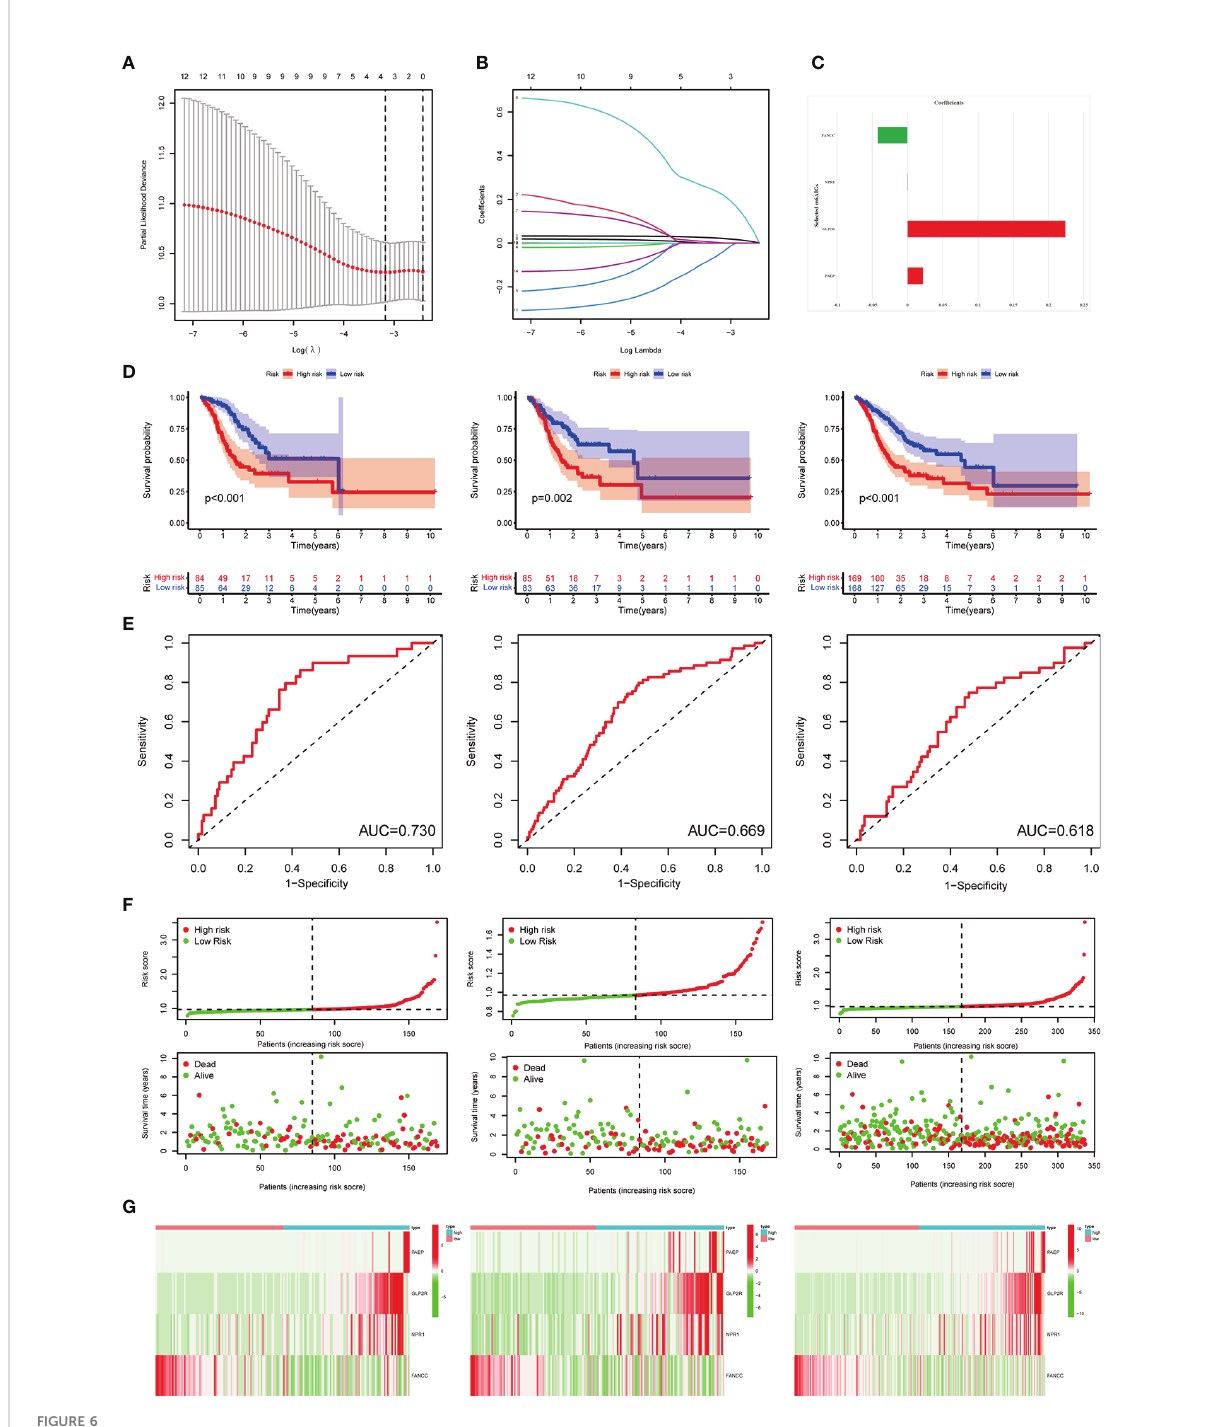
FIGURE 6 Construction and validation of the m 6 AIGs-PS. (A) The number that corresponded to the point with the smallest cross-veri fi cation error was the gene numbers included in the LASSO regression risk model. (B) The lines of different colors represent the trajectory of the correlation coef fi cient of different factors in the model with the increase of Log Lamda. (C) LASSO coef fi cients of 4 selected prognostic m 6 AIGs. (D) KM analysis of patients in the low- and high-risk groups in the training cohort, the test cohort, and the combined cohort. (E) ROC analysis for OS prediction in the training cohort, the test cohort, and the combined cohort. (F) The distribution plots of RS and survival status in the training group, the test group, and the combined group. (G) Heatmap of four-gene pro fi les in the low- and high-risk groups in the training cohort, the test cohort, and the combined